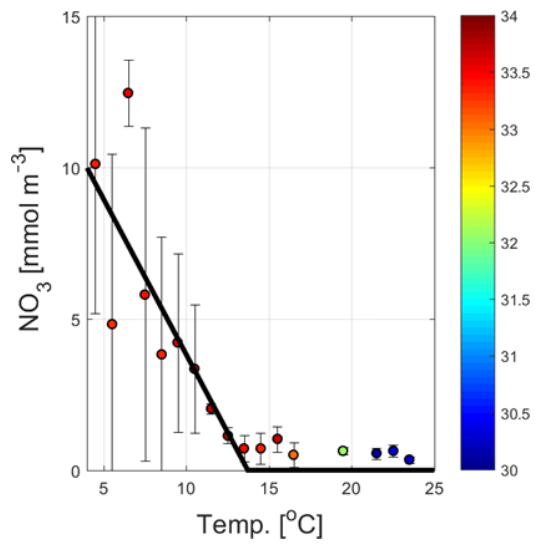
Figure 10. A linear fit (bold line) between temperature (Temp.) and nitrate (NO 3 ) for Temp < 14 . 0 ◦ C (NO 3 = 0 for Temp > 14 . 0 ◦ C) to observations near the east coast of the Korean Peninsula in the summers of 2011 and 2012. Standard deviations for nitrate and ab- solute salinity in g/kg are shown with vertical bars and colors (color bar on the right),